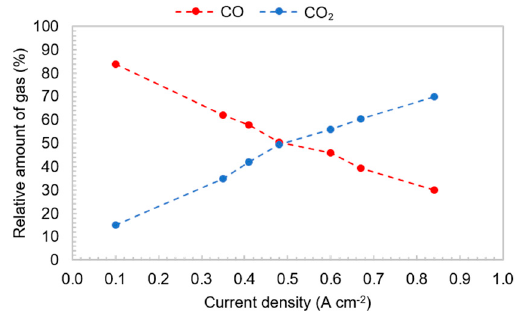
Figure 17. Relative amount of CO and CO 2 versus current density for the hollow gas anode.